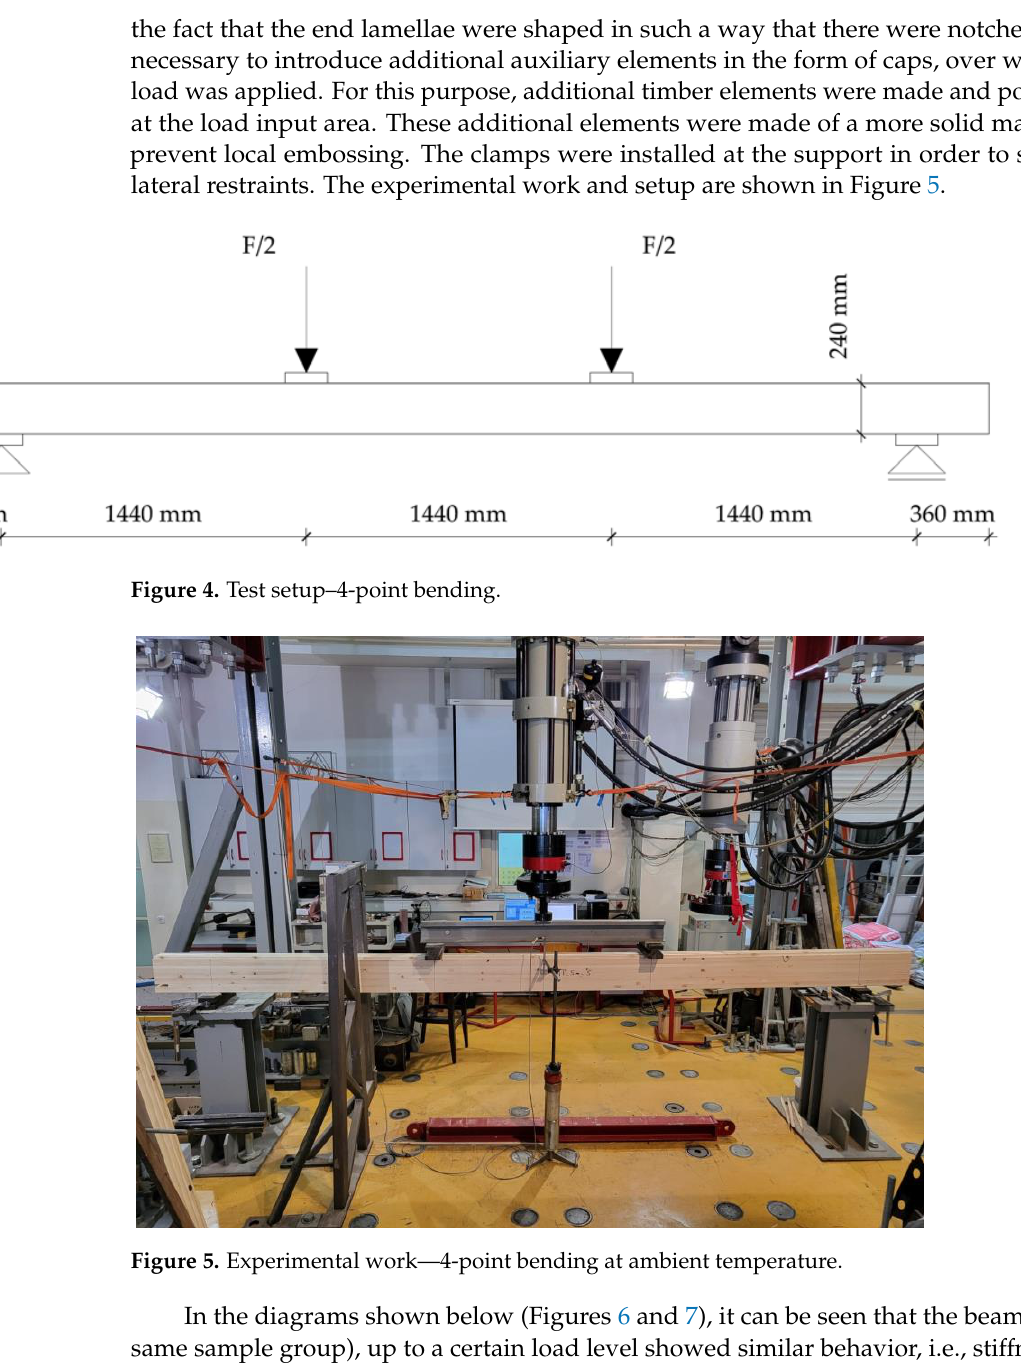
Figure 5. Experimental work—4-point bending at ambient temperature.